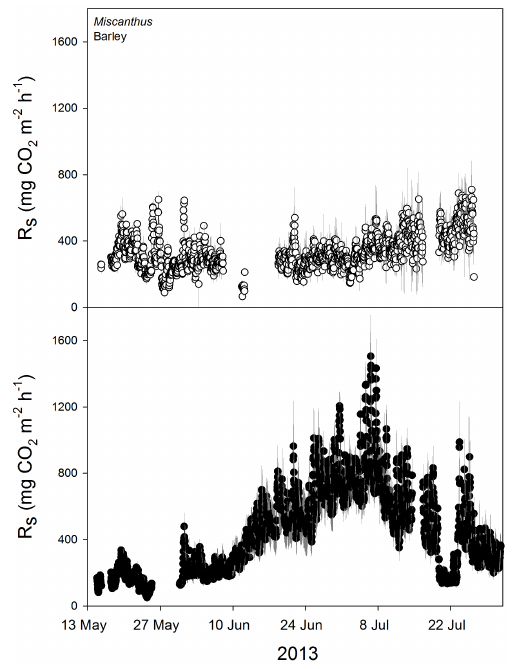
Figure 1. Mean ( ± 1SE, n = 6) R s from under Miscanthus (top panel) and barley crops (bottom panel) during summer 2013, mea- sured using LI-COR automatic flux